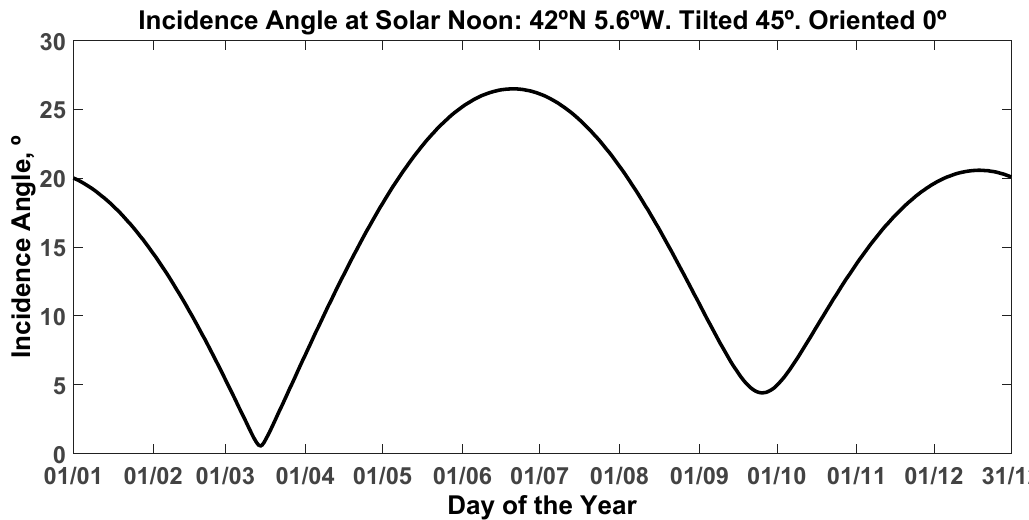
Figure 8. Incidence angle at solar noon calculated at latitude 42° N and longitude 5.6° W for all days of the year. 3.5. Results for Hourly Global Irradiance and Hourly Mean Solar Irradiance on the Solar Panel